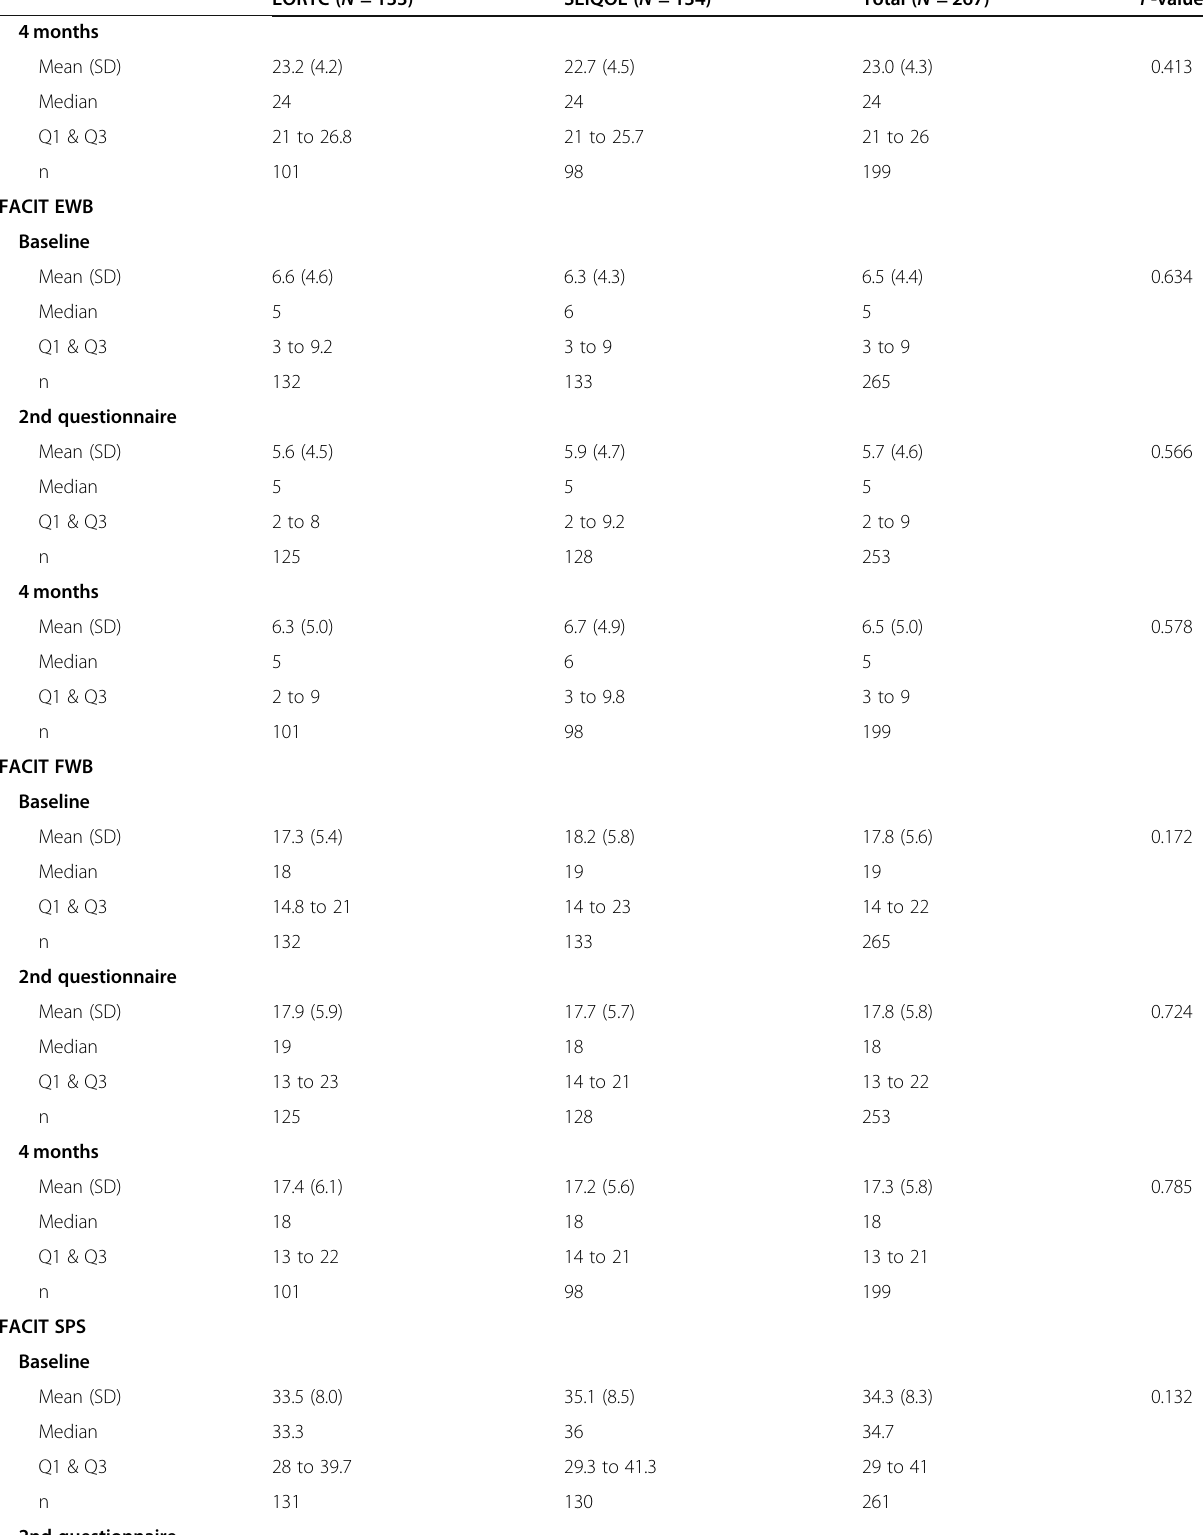
Table 2 Outcomes a over time for analyzed patients